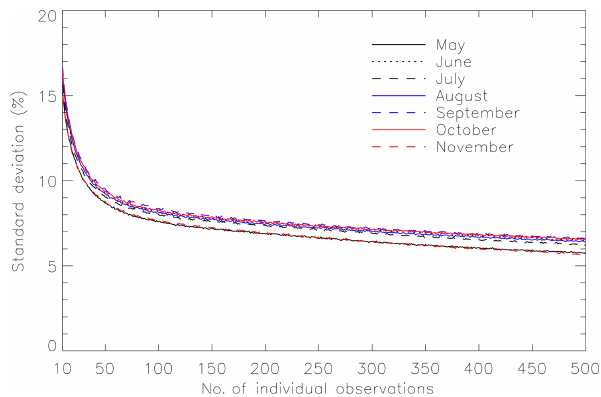
Figure 6. Expected dispersion (in %) of CHOCO-D as a function of the number of wind direction observations used to compute it ( x axis) for May to